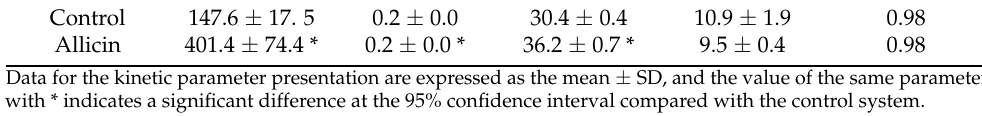
Figure 6. Logistic-exponential kinetic model fitting curves for acrylamide contents in allicin. ( a ) AA content without garlic powder soaking treatment; ( b ) AA content with garlic powder soaking treatment.